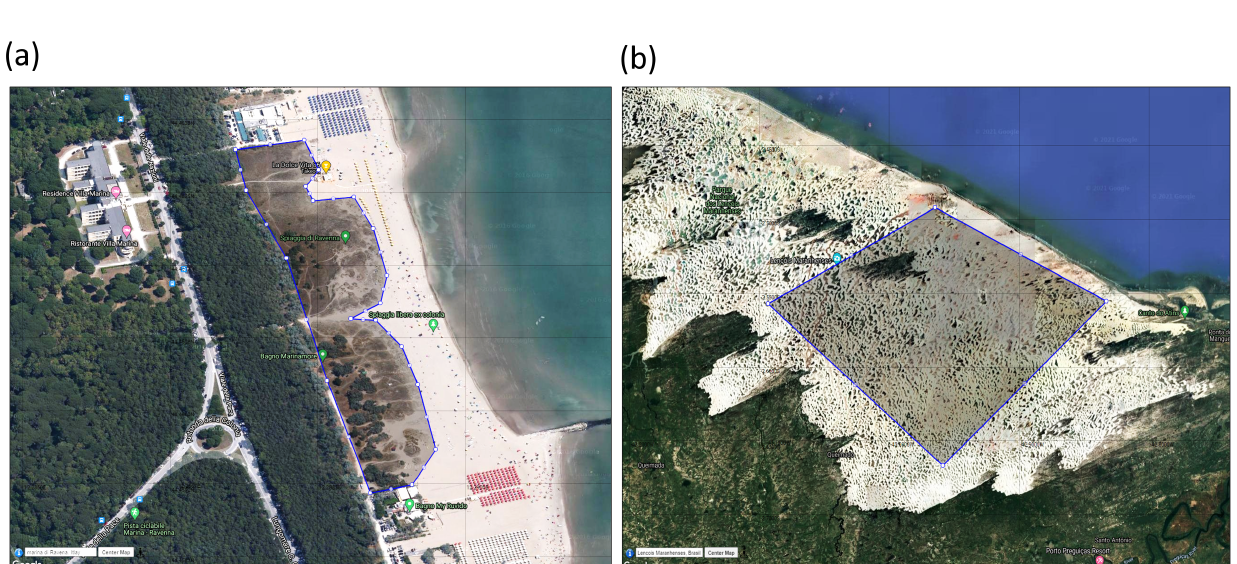
Figure 2. Examples of region of interest (ROI; shaded area bounded by blue line with white dots) for selected coastal dunefields: ( a ) Marina di Ravenna beach, Italy; and ( b ) Lençóis Maranhenses in NE Brazil. Source: Google Earth Pro